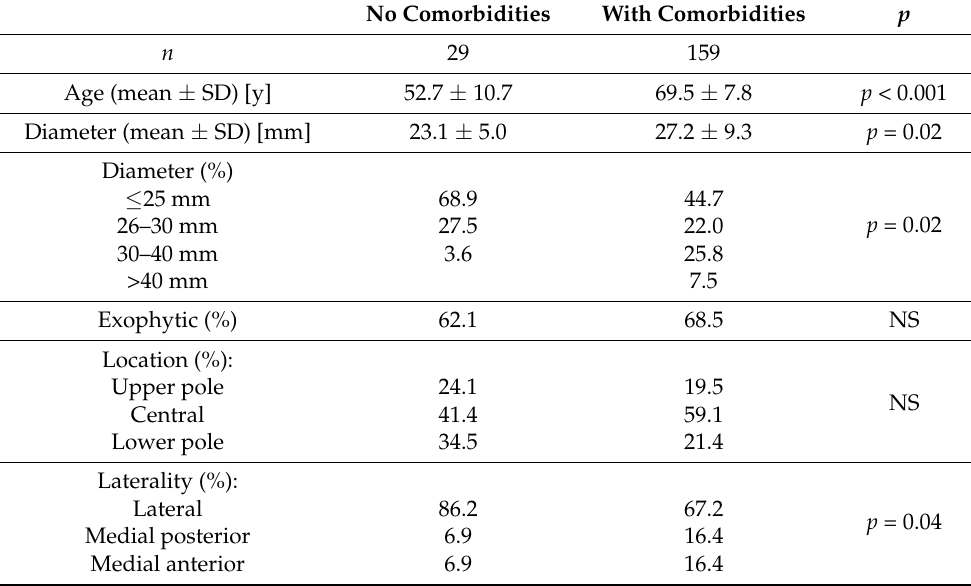
Table 3. Characteristics of ablated tumours in patients with and without